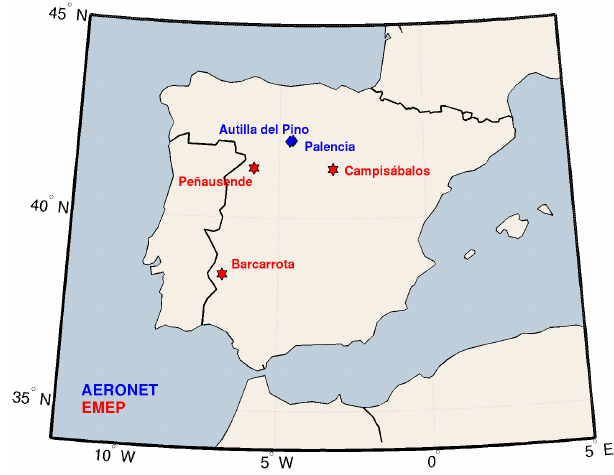
Figure 1. Location of the main sites used in this study belonging to AERONET (blue diamonds) and EMEP (red stars)